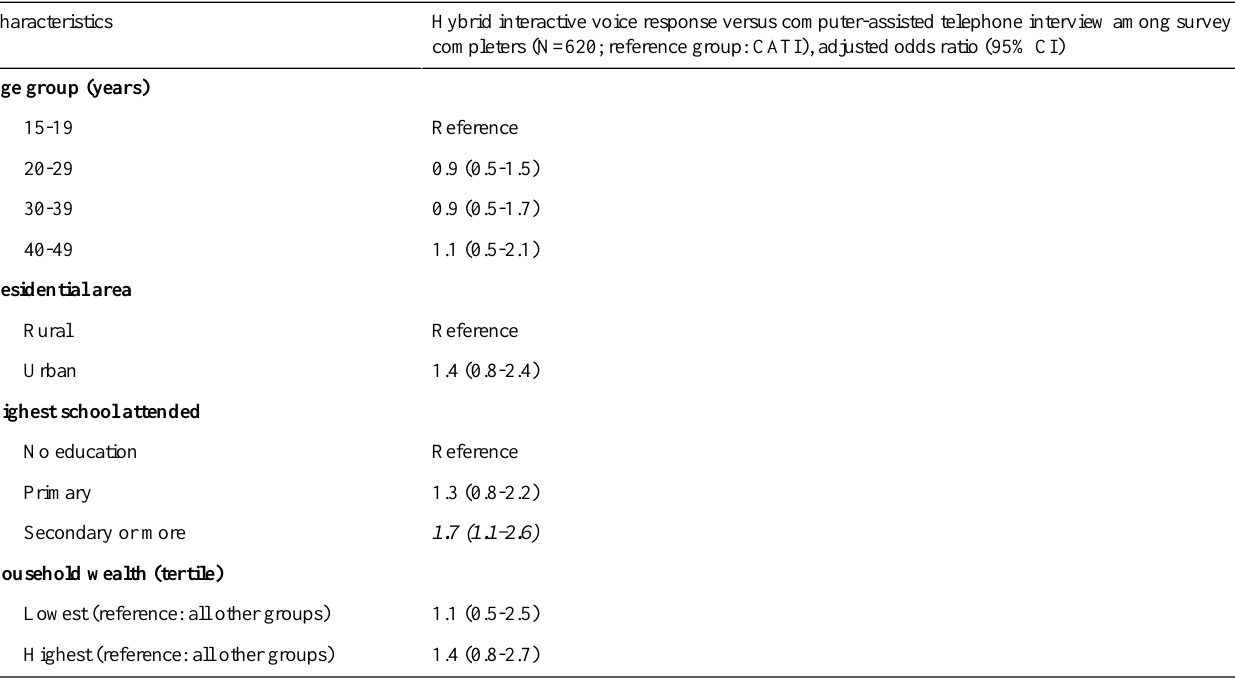
Table 6. Odds of completing the hybrid interactive voice response survey compared with completing the computer-assisted telephone interview survey by background characteristics: multivariable logistic regression analyses. Italics indicates P value below .05. Hybrid interactive voice response versus computer-assisted telephone interview among